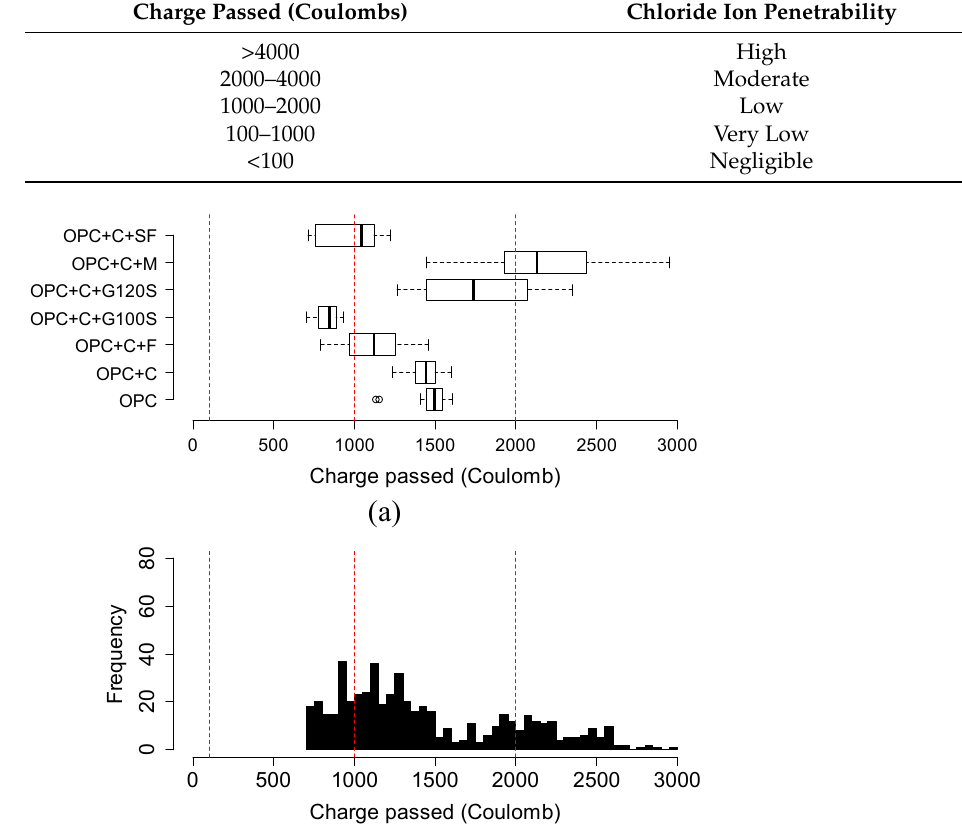
Table 3. Chloride Ion permeability based on charge passed according to ASTM C1202 [25].